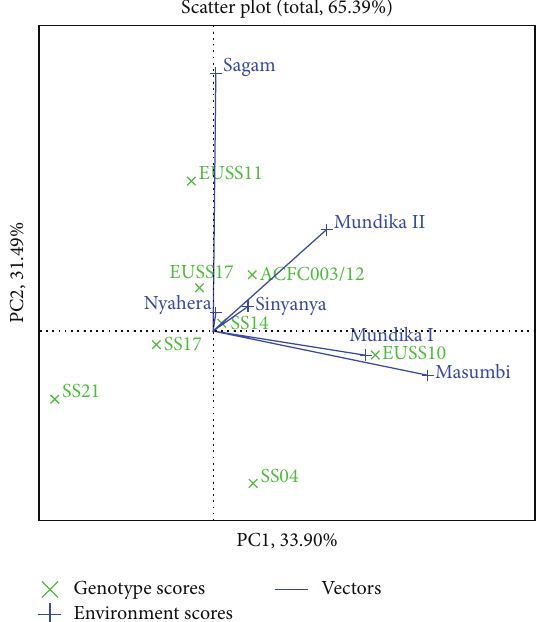
Figure 7: The biplot showing relationship between testers and mega environments for juice yield.